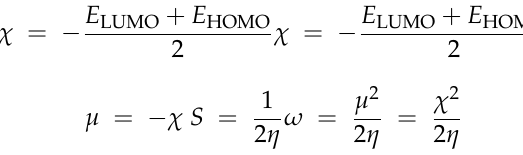
Table 5. The calculated quantum chemical parameters of the Schiff base (HL) and Cu(II) complex. Compound